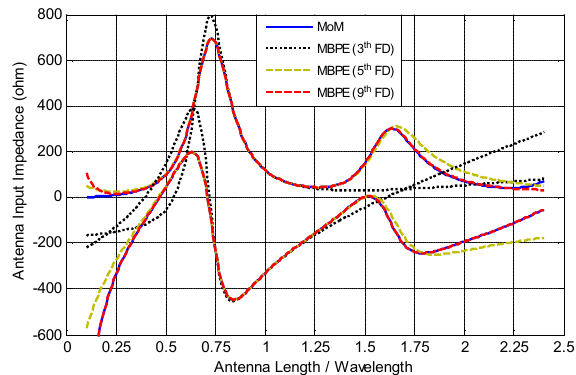
Figure 7: Input impedance of the thin-wire antenna calculated regular MOM and MBPE technique with 3 th , 5 th and 9 th frequency